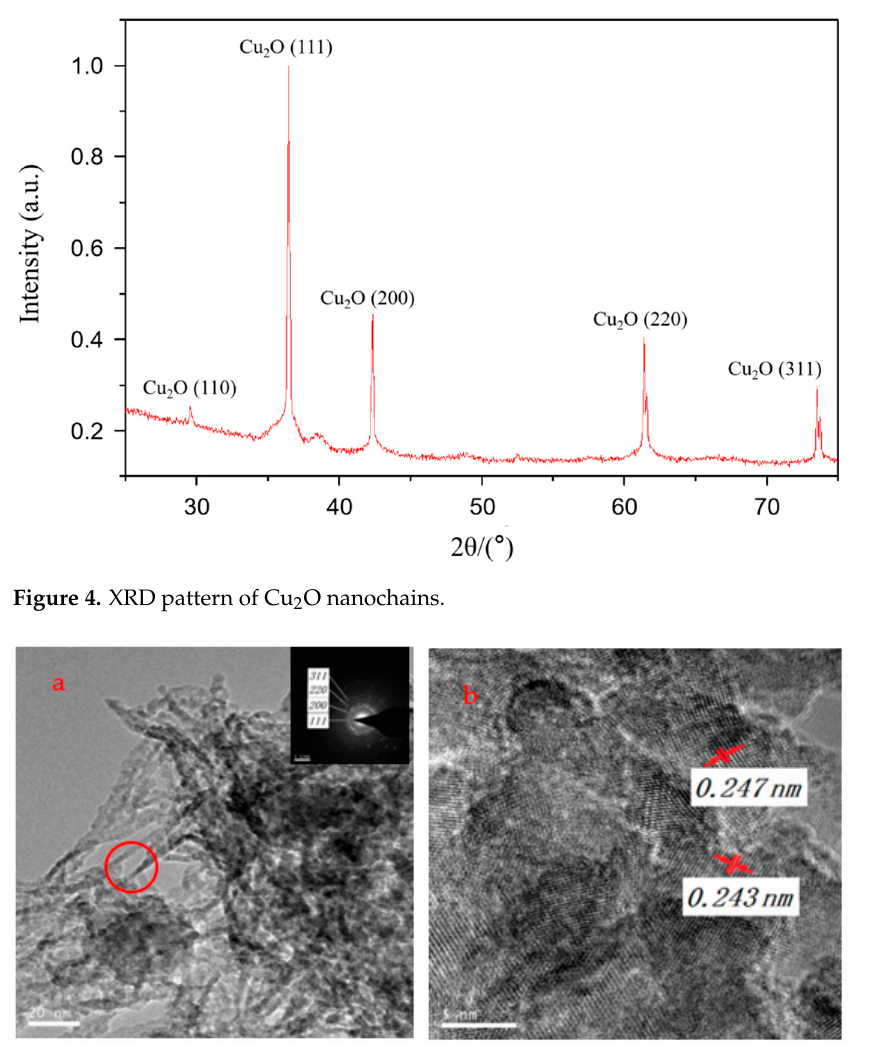
6 of 14 Figure 3. The apparatus for evaluating the light-thermal conversion performance [28]. 3. Results and Discussion 3.1. The Characterization of Cu 2 O Nanochains Figures 4 and 5 show the XRD images and TEM images of Cu 2 O nanochains, respec-